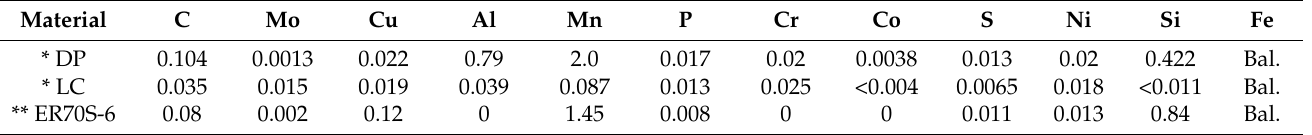
Table 1. Chemical composition of DP, LC steel and ER70S-6 filler metal (wt. %).